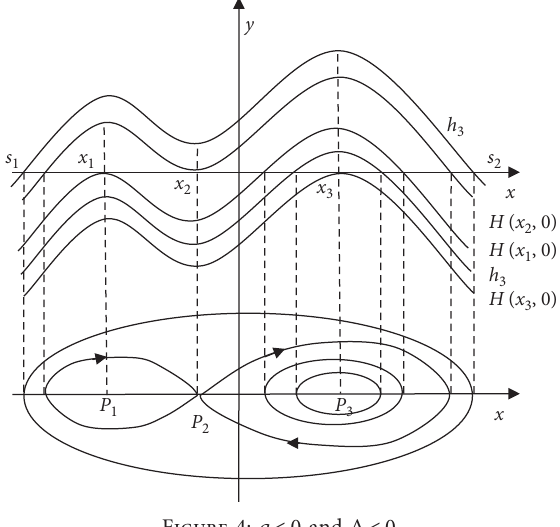
Figure 4: q < 0 and Δ < 0. Figure 5: q > 0 and Δ �